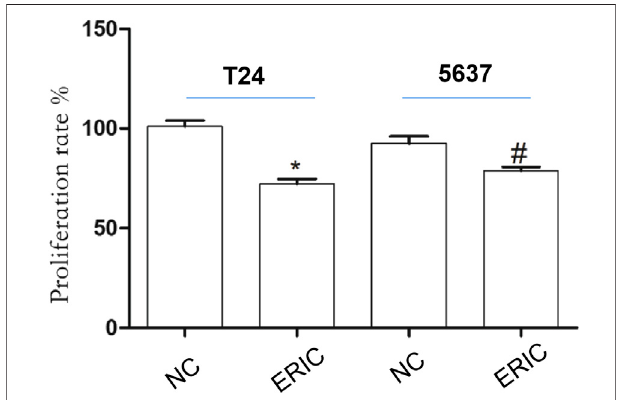
FIGURE 5 | Changes in cell proliferation rate in each group. The proliferation rate was determined by MTT assay. The mean value ± SD was shown. * p < 0.05. # p < 0.05.